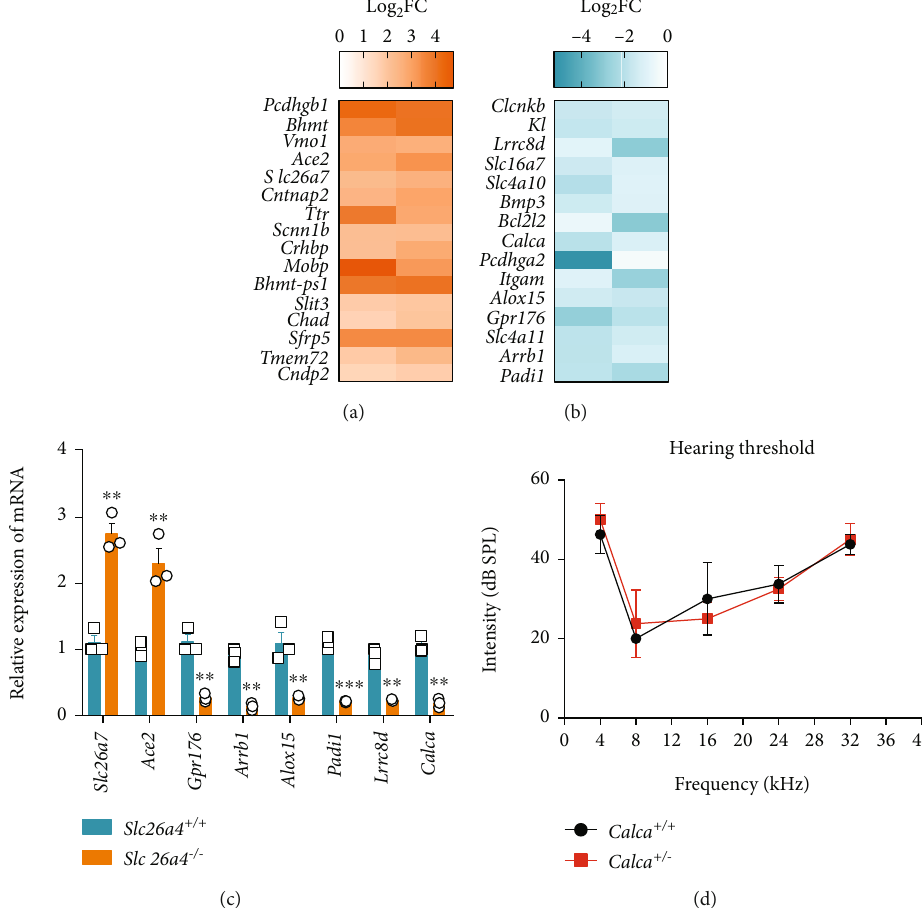
Figure 4: Validation of di ff erentiated expressed genes in stria vascularis of Slc26a4 deletion. (a, b) Heatmap indicated selected upregulated genes (a) and downregulated genes (b) in Slc26a4 -/- SVs. (c) Quantitative RT-PCR analysis of expression of indicated genes in Slc26a4 -/- SVs. (d) ABR test of wildtype and Calca +/- mice. ∗ p < 0 : 05 and ∗∗ p < 0 : 01 by the unpaired t -test (c). Data are from three independent experiments with biological duplicates in each (c, d; mean ± s : e : m : of n = 3